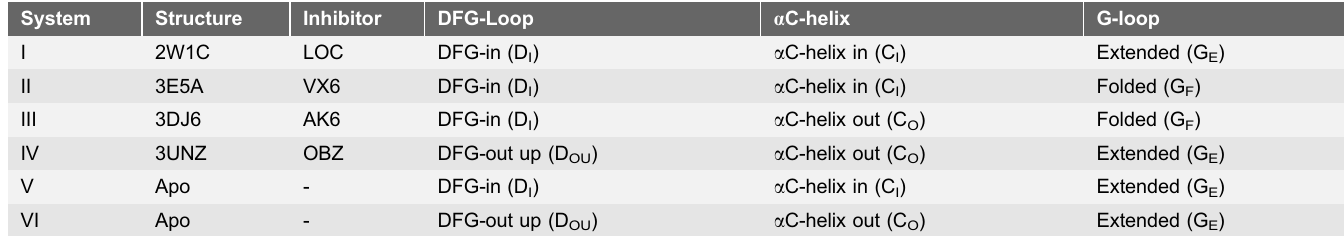
Table 1. Details of the systems subjected to MD